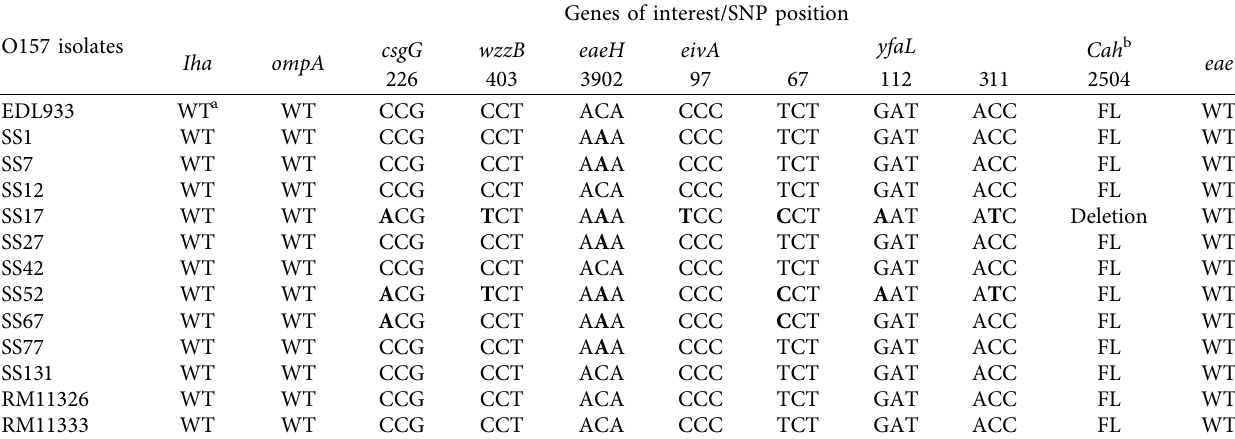
Table 2: SNP position and nucleotide change across 9 genes in SS isolate genomes when compared to the EDL933 genome. O157 isolates